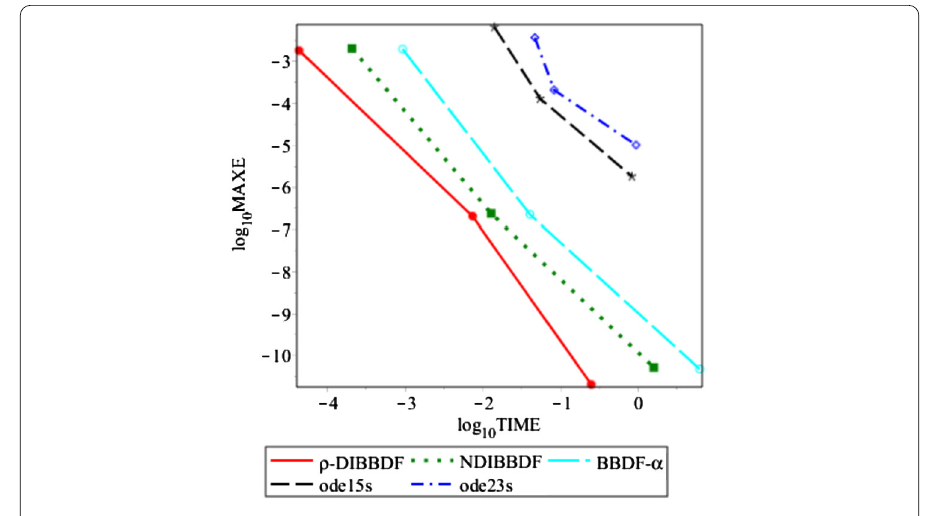
Figure 7 Graph for log 10 MAXE against log 10 TIME of Model B(i) Table 6 Numerical results for concentration of drug in Model B—Compound (ii) h